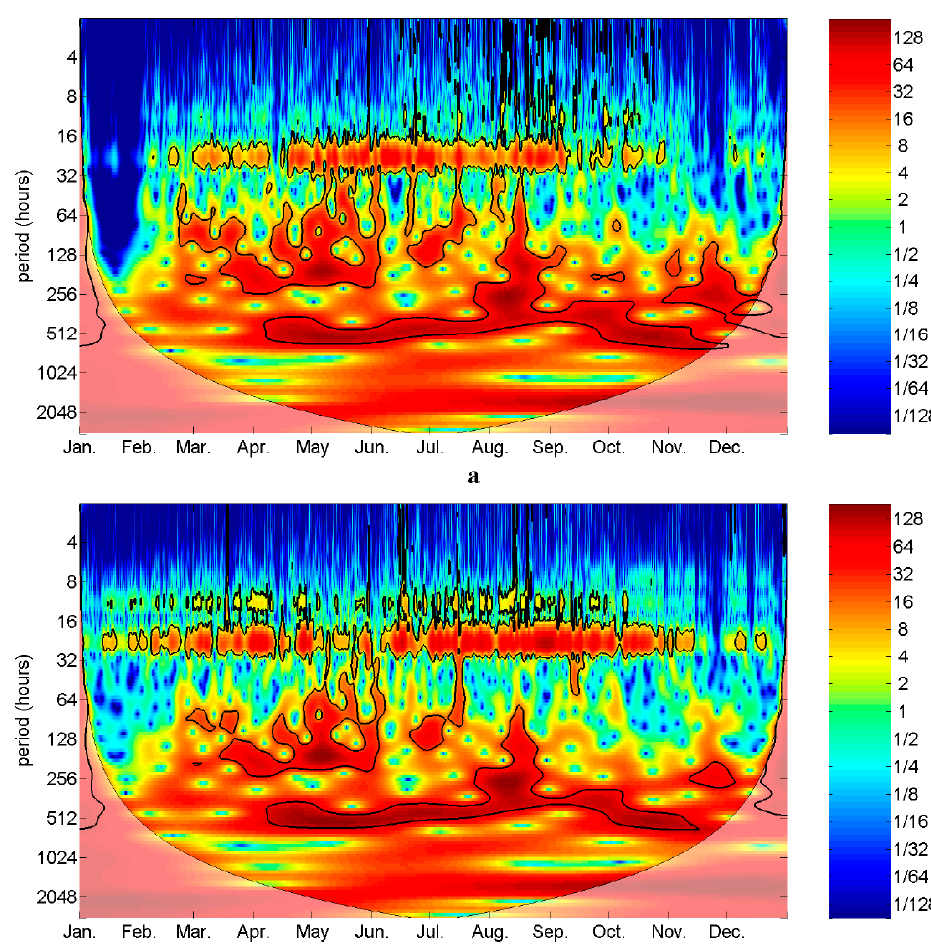
Figure 8. Continuous wavelet transform analysis of hourly water temperature time series of Suceava River in 2019: ( a ) Mihoveni, ( b ) Ti şă u ţ i.